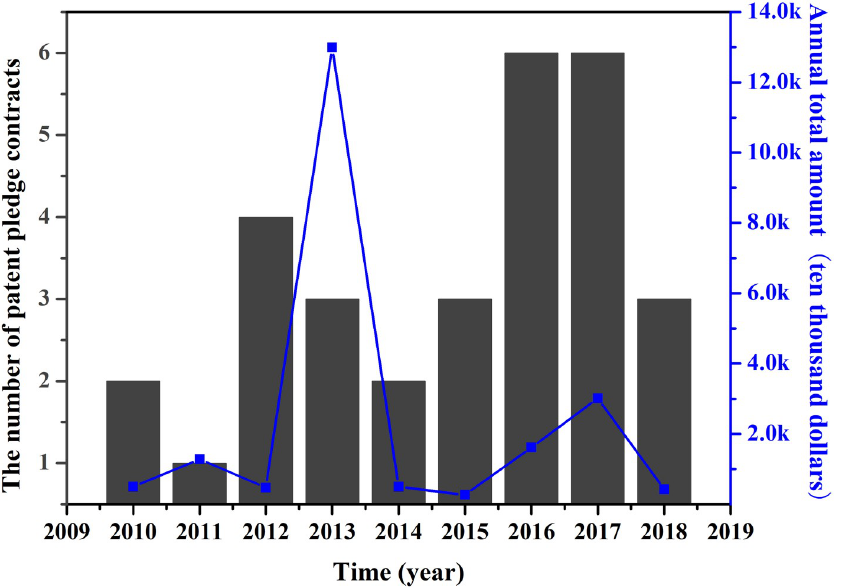
Fig 2. The number of patent pledge contracts and the annual total amount over